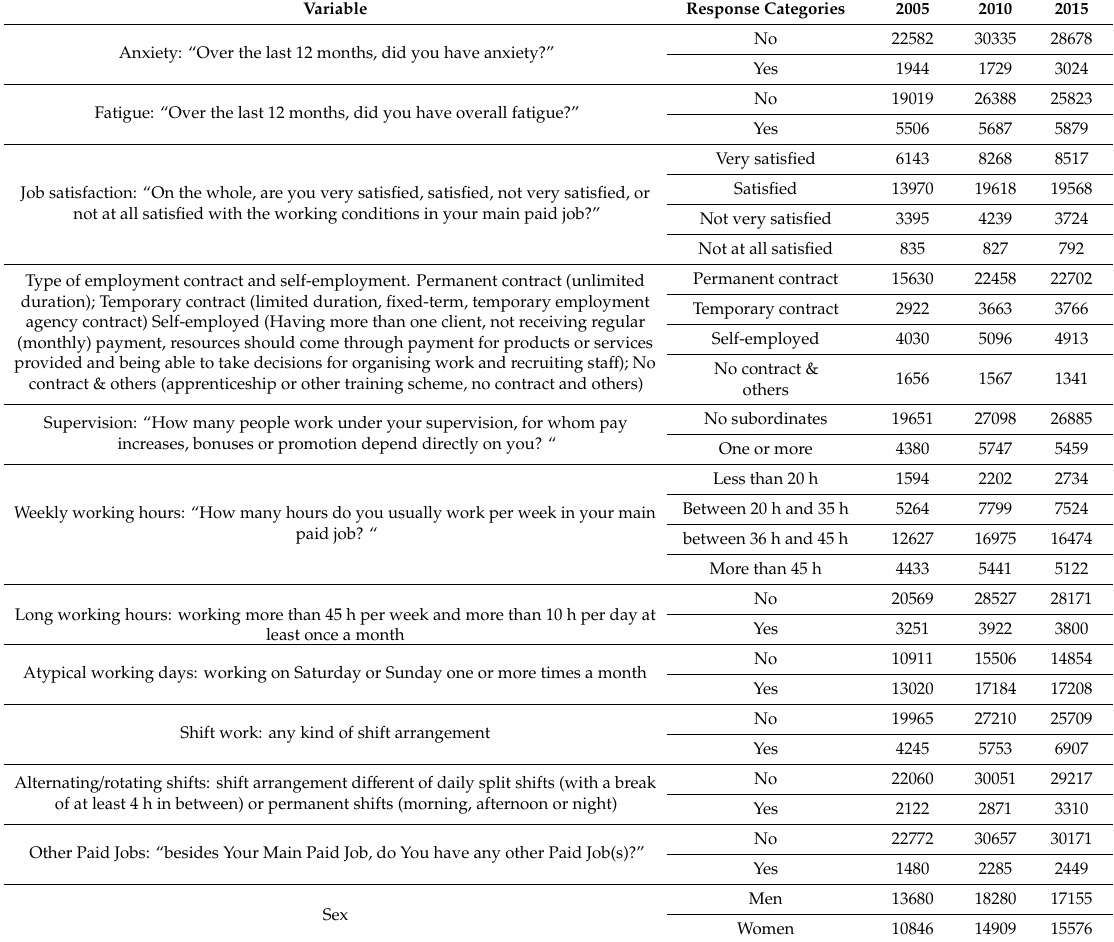
Table A1. Definition of all variables and descriptive statistics for each